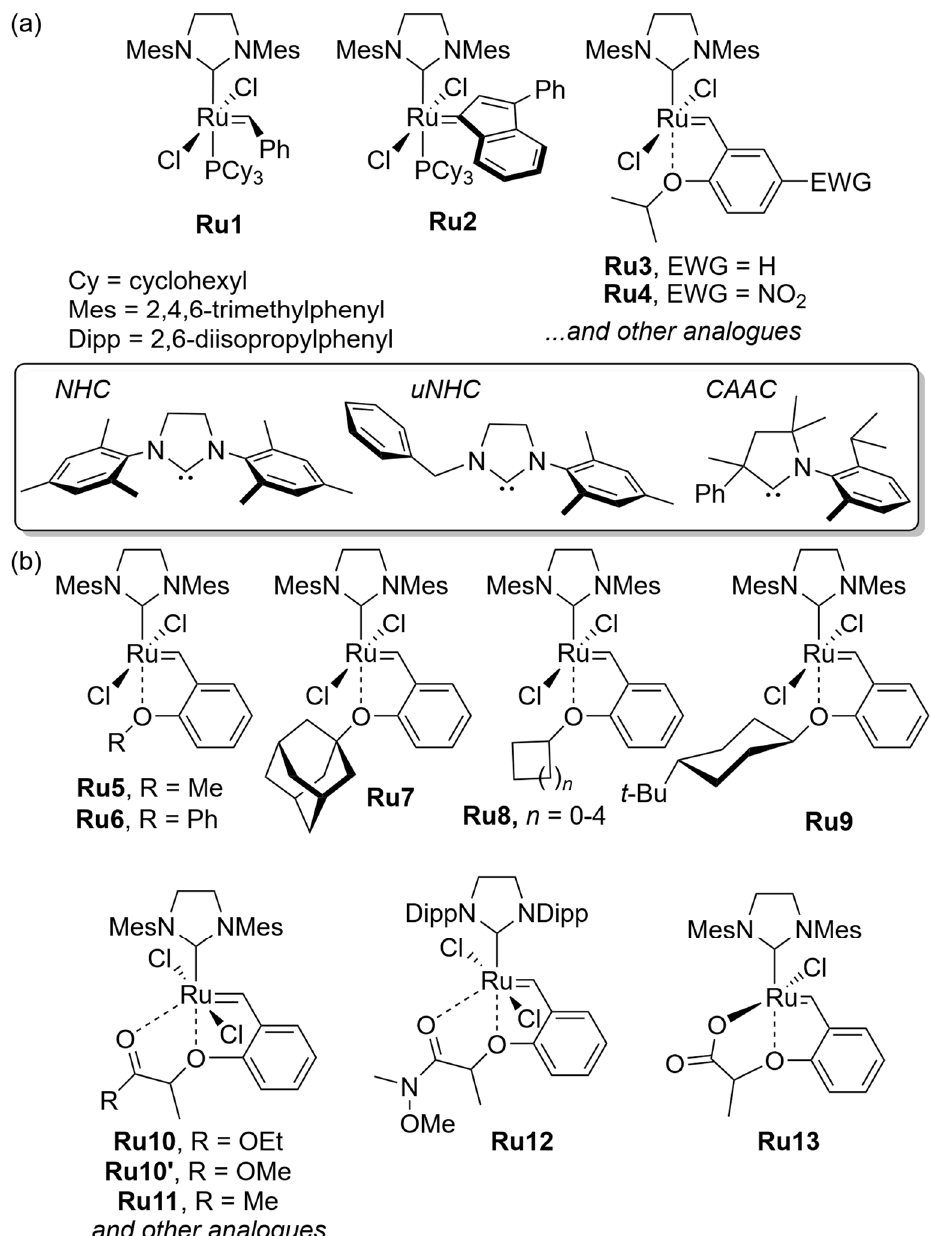
Figure 1. Selected ( a ) commercially available ruthenium-based general-purpose olefin metathesis catalysts and the structures of NHC, uNHC, and CAAC, and ( b ) selected ether-modified chelating benzylidene complexes.